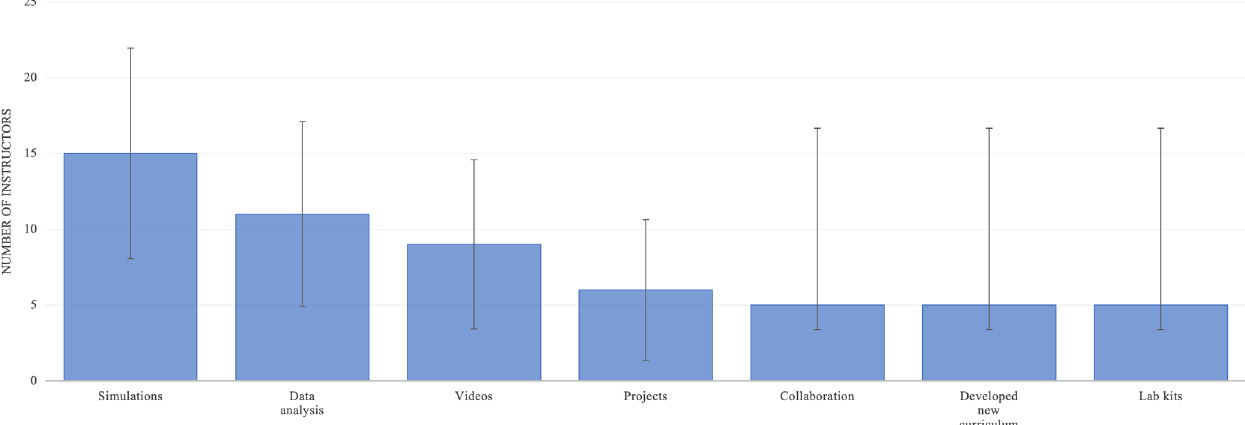
FIG. 2. The successes referenced by instructors in the open responses of the survey. The error bars were calculated using the 95% binomial confidence interval with n ¼ 91 , number of references to any success by the instructors. Note, there were 22 success subcodes — we present only the subcodes that are statistically above zero (using the 95% confidence interval) in this